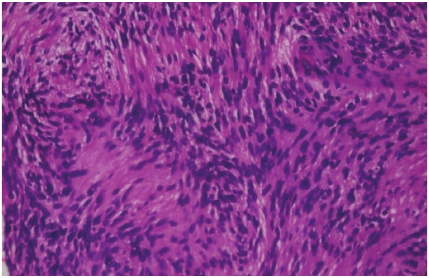
Figure 6: Photomicrograph showing nuclear palisading with Vero- cay bodies (Antoni A areas) (H&E